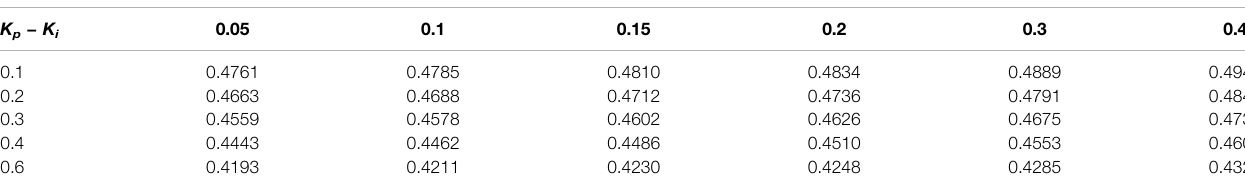
TABLE 5 | Delay margins for K d (cid:2)